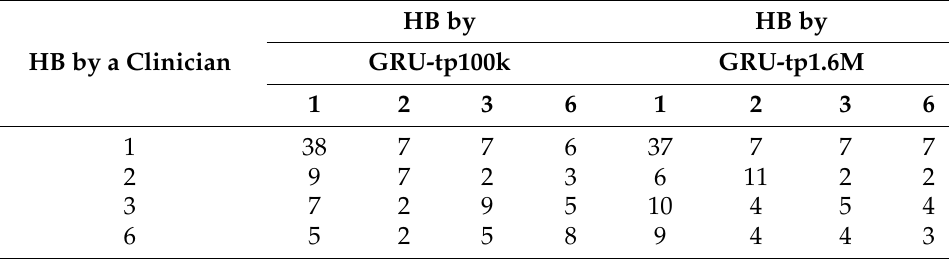
Table 3. Confusion matrix with numbers of (mis)classified cases by GRU neural network structures on a test set (tp marks the number of trainable parameters).